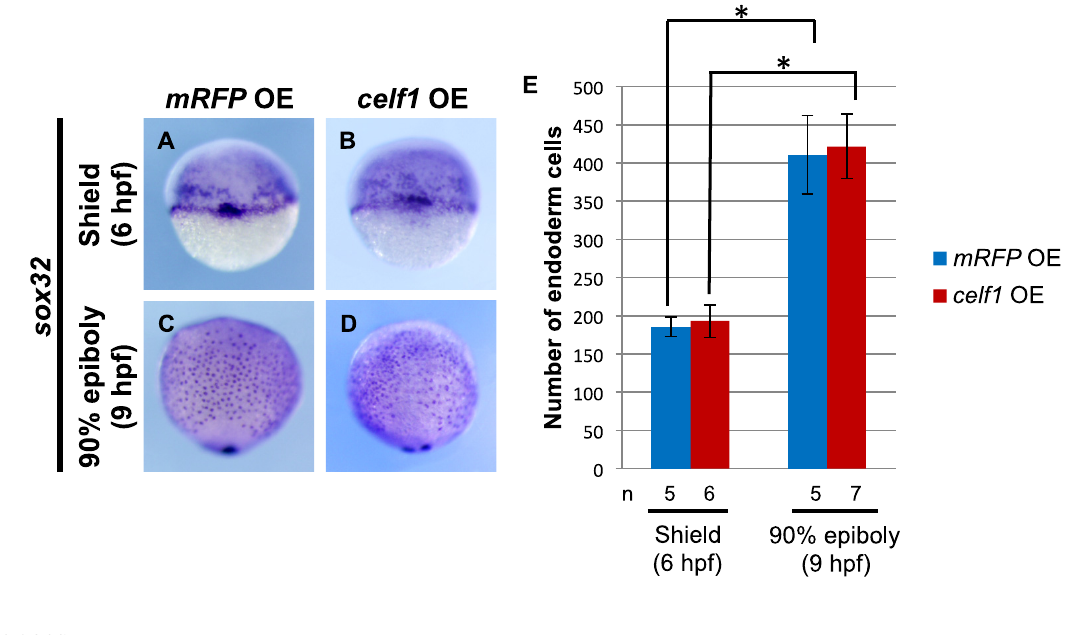
Figure A4. Effect of celf1 overexpression on endoderm proliferation. ( A – D ) sox32 expression in endoderm cells at 6 ( A , B ) and 9 hpf ( C , D ) in mRFP OE ( A , C ) and celf1 OE embryos ( B , D ). Anterior to the top. ( E ) Overexpression of celf1 did not affect endoderm proliferation. Asterisks indicate statistically significant differences (* p <